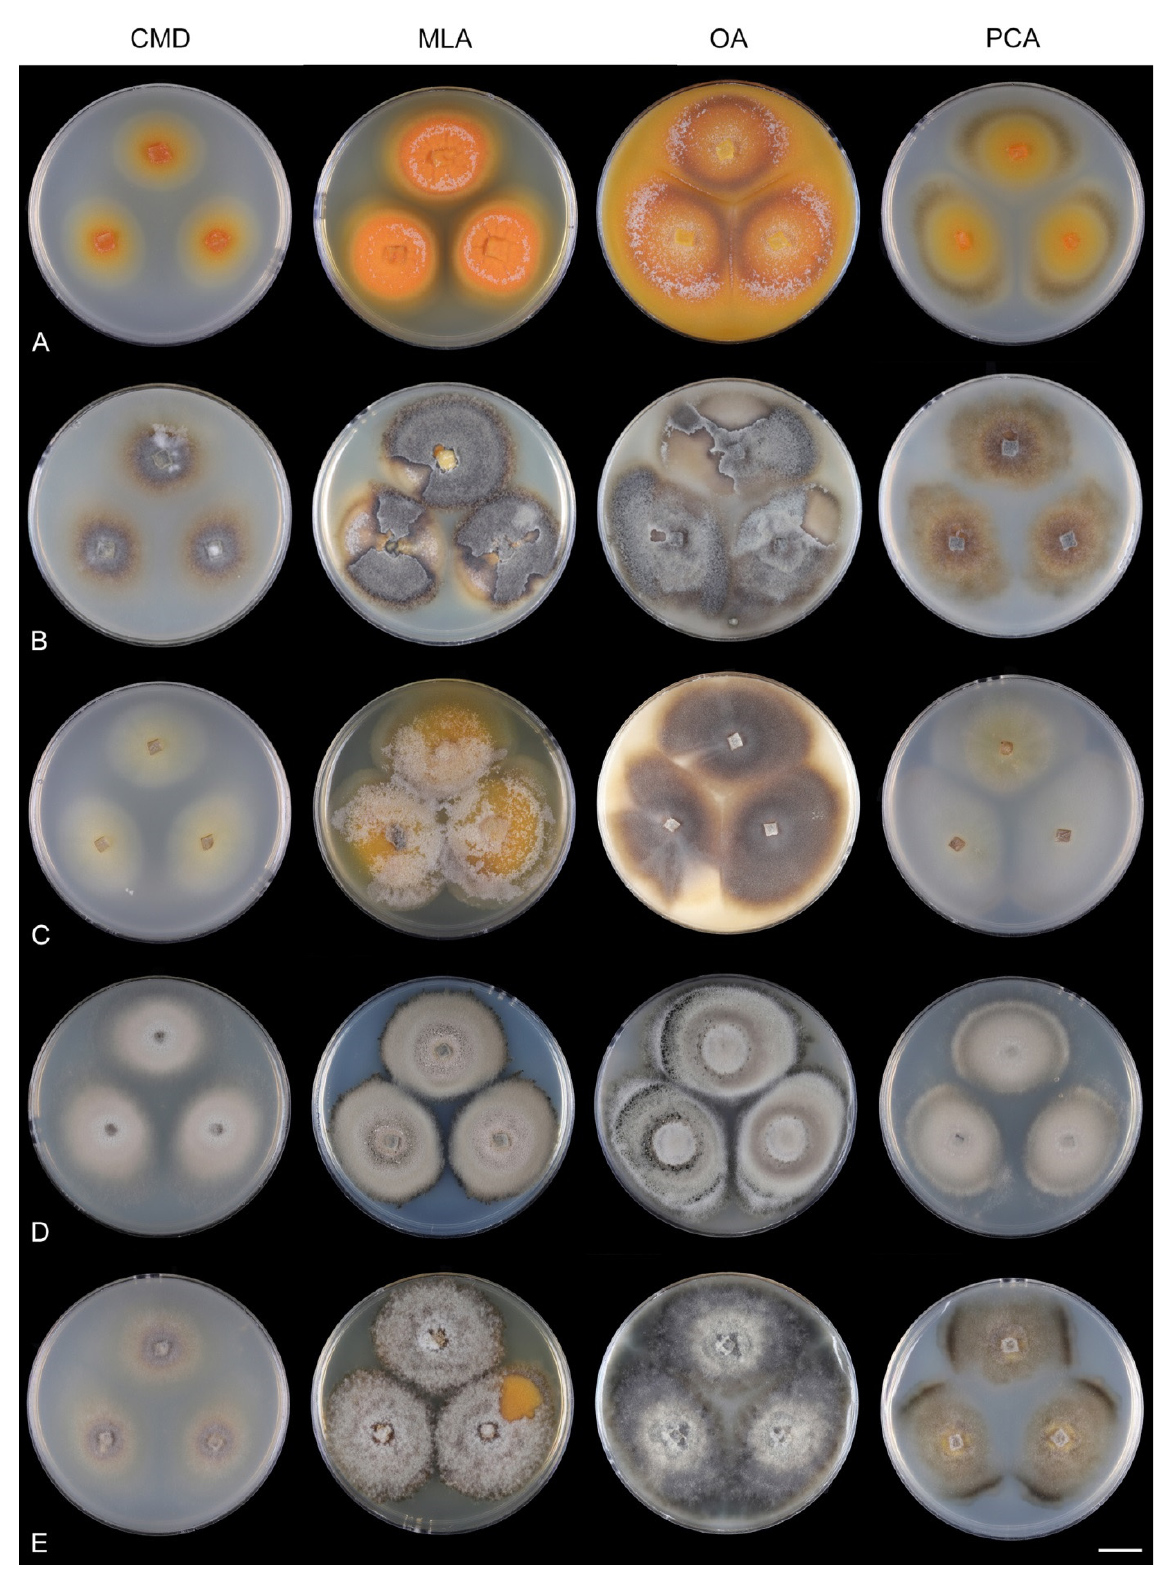
Figure 28. Colony morphology of Codinaeella minuta after 4 weeks. ( A ) CBS 966.69 ( B ) CBS 146621 ( C ) CBS 115959 ( D ) DAOM 148141 ( E ) ATCC 20960. Scale bar: ( A – E ) 1 cm.